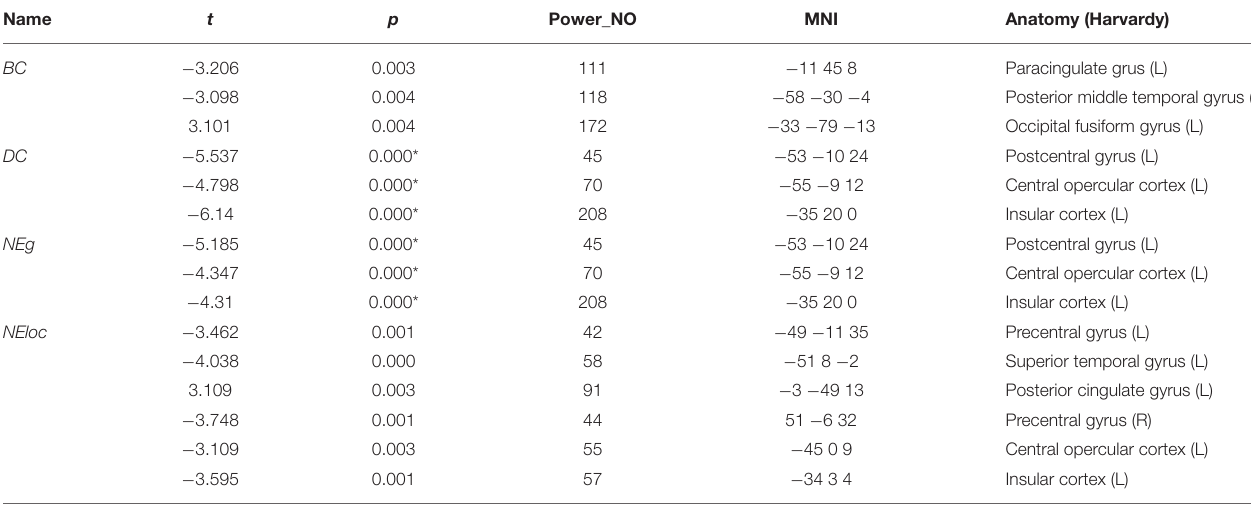
TABLE 2 | Between-group differences in nodal characteristics in patients with aphasia and healthy